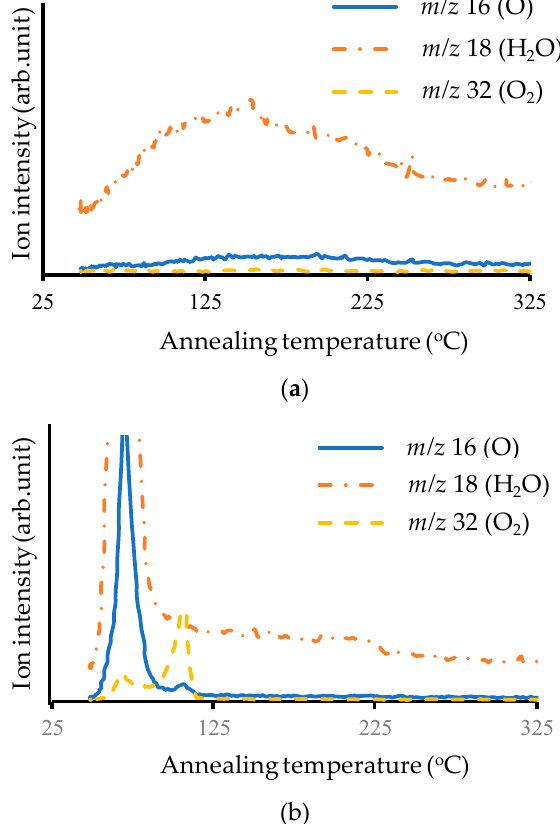
Figure 7. Results of TDS analysis: ( a ) with Ar plasma treatment; ( b ) with O 2 plasma treatment.